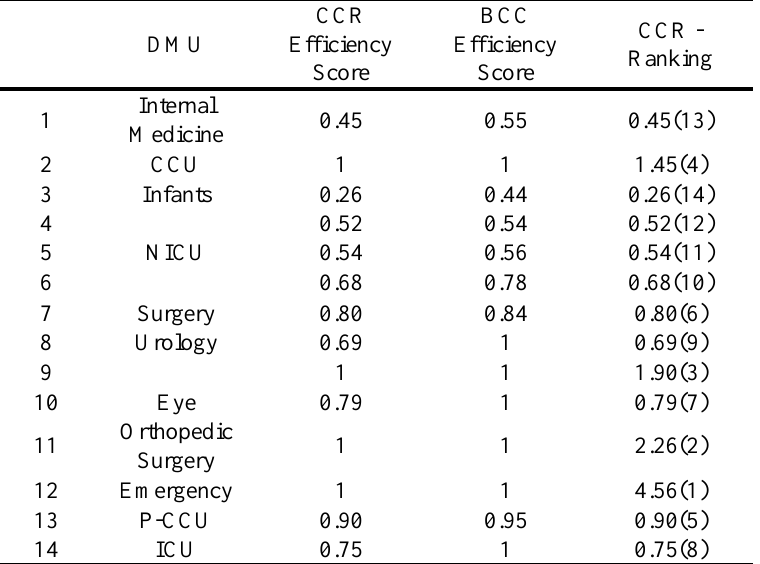
Table 4 represents six efficient units in CCR model and nine efficient units in BCC model. MPSS units are units #2, #9, #10, #11, #12, and #13. Obviously, BCC model demonstrates more efficient units. Top of all, the unit #12 has the highest rank between the data set evaluated in this year. Testing the data set of third year, Table 4 records the relative efficiency scores and ranking orders in this year. Table 5. Efficiency score and ranking in case study application in year 1391. CCR DMU Score